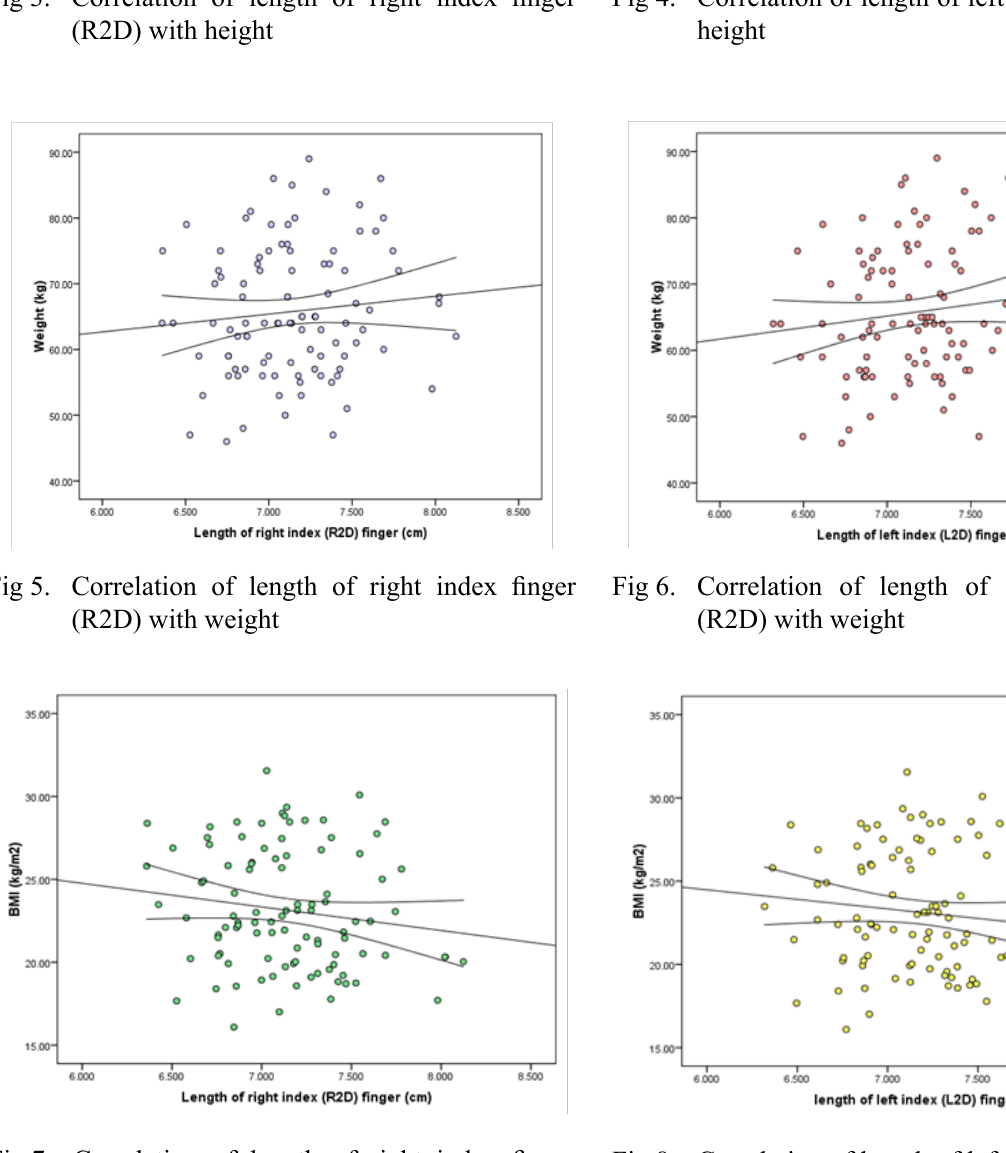
Fig 8. Correlation of length of left index finger with BMI